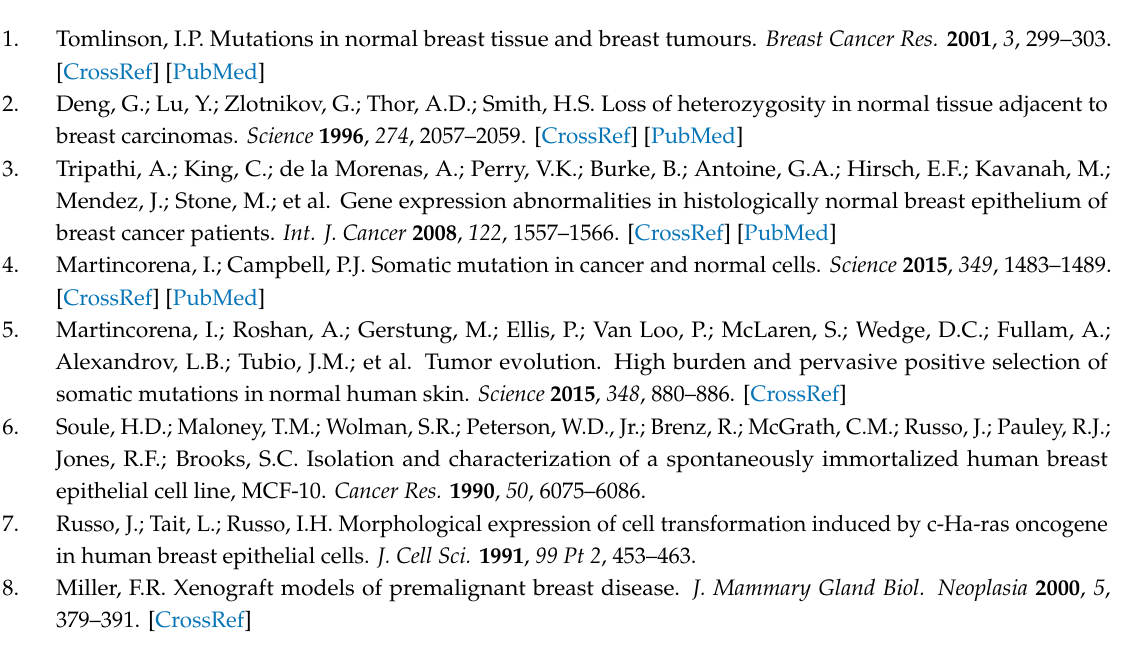
Figure S1: Heat map showing the expression pattern of all miRNAs (n = 450) that changed across the spectrum of breast cancer progression, Figure S2: Line diagrams showing the K-means clustering to group miRNAs, Figure S3: qPCR validation of significantly changing miRNAs in the MCF10A-based breast cancer progression panel, Figure S4: Heat maps showing the expression pattern of mRNAs that change significantly across the MCF10A model of breast cancer development and are predicted regulators of DICER by miRTarBase and TargetScan algorithms, Figure S5: miRNA-29c-3p does not regulate DICER, Figure S6: let-7b-5p and prognosis in basal like breast cancer subtype patients, Figure S7: Heat map showing the expression pattern of mRNAs that change significantly across the MCF10A model of breast cancer development, Figure S8-S11: qPCR validation of significantly changing genes in the MCF10A-based breast cancer progression panel, Figure S12: Line diagrams showing the K-means clustering to group mRNAs in one of the 8 predefined patterns, Figure S13: Line diagrams showing the K-means clustering to group pathways in one of the 8 predefined patterns, Figure S14: miRNAs that increased continuously and their target genes and target pathways that decreased continuously during breast cancer progression (Group 1), Figure S15: miRNAs that increased and their target genes that decreased during preneoplastic to invasive transition in breast cancer progression (Group 3), Figure S16: miRNA that increased, and their target genes & target pathways that decreased during DCIS to invasive transition in breast cancer progression (Group 4), Figure S17: miRNA that decreased, and their target genes that increased during preneoplastic to invasive transition in breast cancer progression (Group 6), Figure S18: miRNA that decreased, and their target genes that increased continuously in breast cancer progression (Group 8), Table S1: miRNA driven gene mediators and pathways per group that are deregulated in breast cancer progression, Table S2: Networks-target pathways that are deregulated per group, Table S3: Primer sequence, assay ID and extent of gene knock down, Table S4: Curated RNA seq data from MCF10A progression